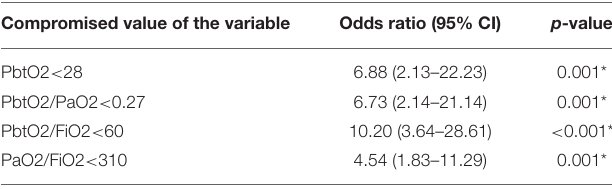
TABLE 2 | Odds Ratio (95% confidence interval) and p -value of death detection using the dichotomized version of each variable (variable < Optimal Threshold). Compromised value of the variable Odds ratio (95% CI) p -value PbtO2 < 28 0.001* PbtO2/PaO2 <